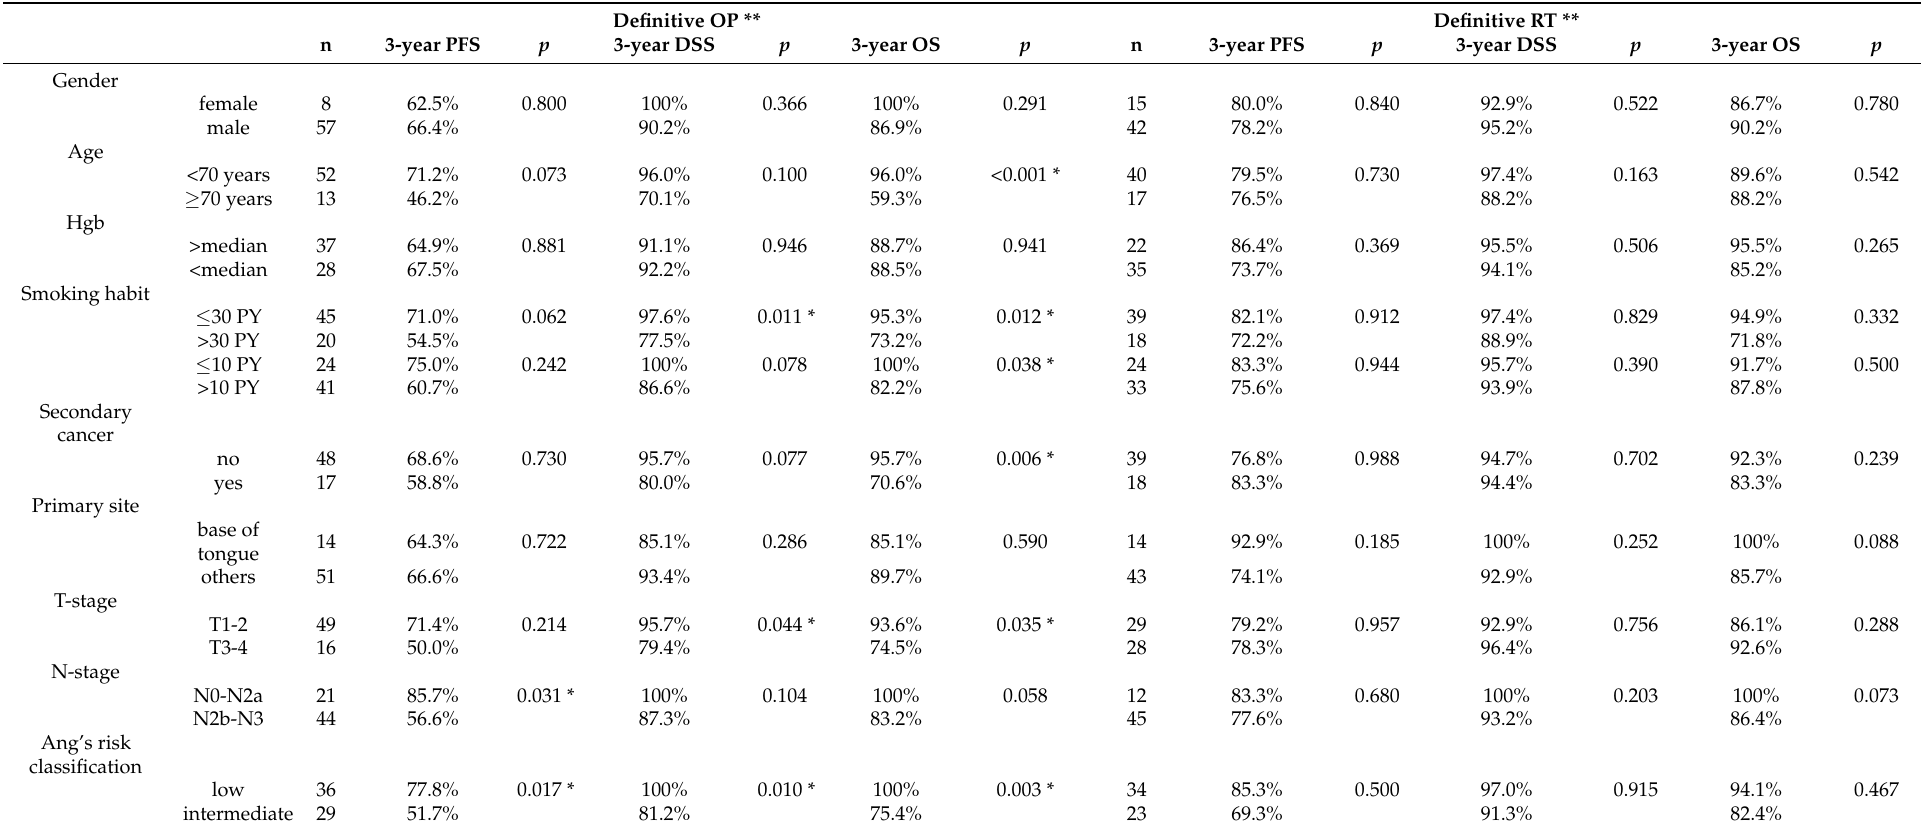
Table 3. Separate univariate analyses for the patients undergoing definitive surgery and radiation